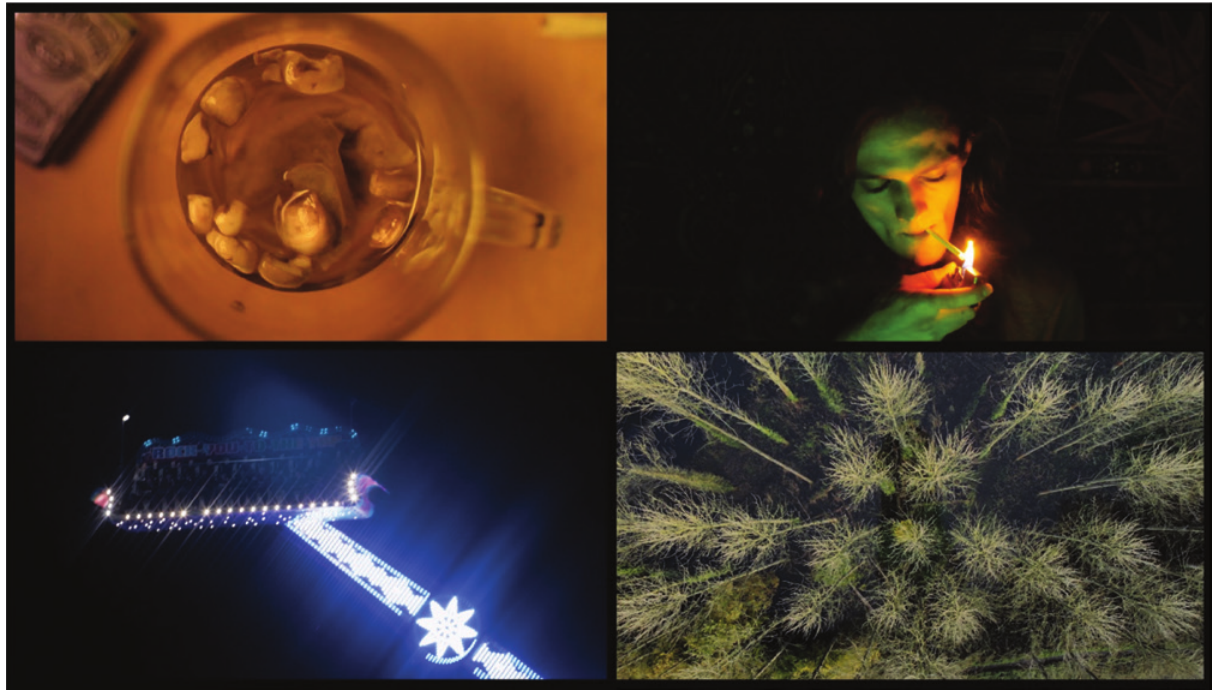
Figure 1. Various shots from An Invincible Summer (Lindsay Mead and Joe Scott, 2019): ‘magic mushroom brew’; protagonist lighting a cigarette; night-time funfair rides; drone shot of a